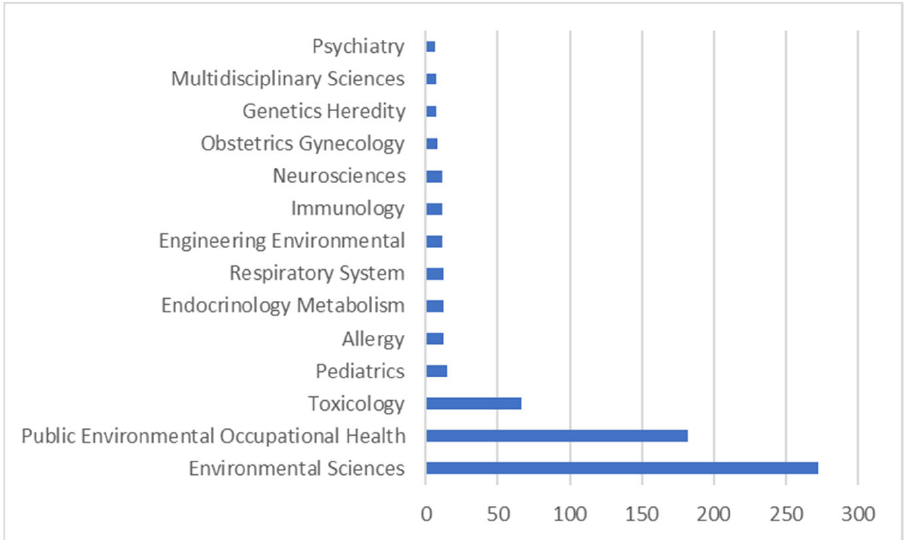
Figure 5. The top 15 disciplines with the highest publications on prenatal exposure to air pollu ‐ tion.